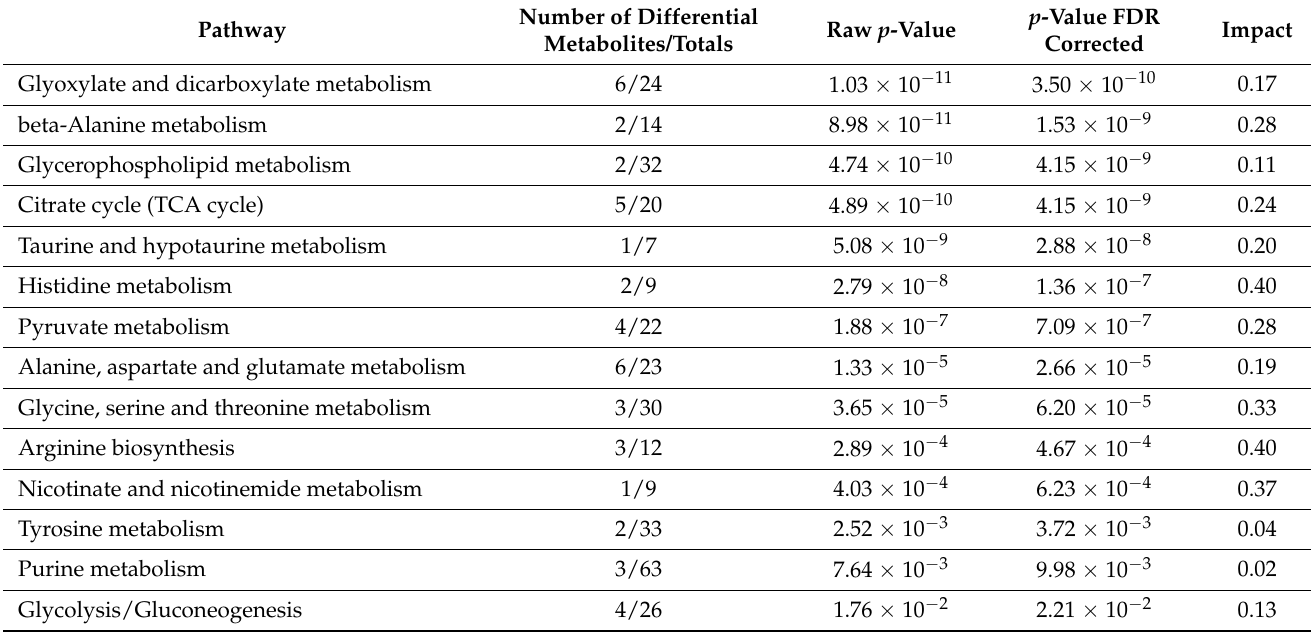
Table 2. Most relevant pathways altered in 15-day-old DJ-1 β mutants compared to control flies. Pathway